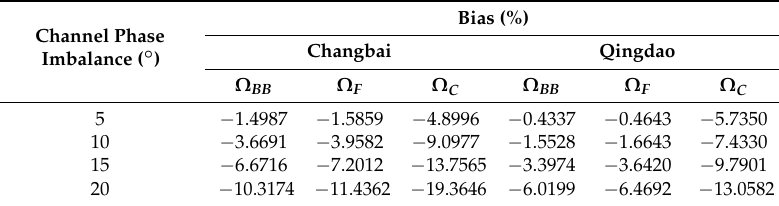
Table 5. Bias ( σ bias ) under the condition of channel phase imbalance.